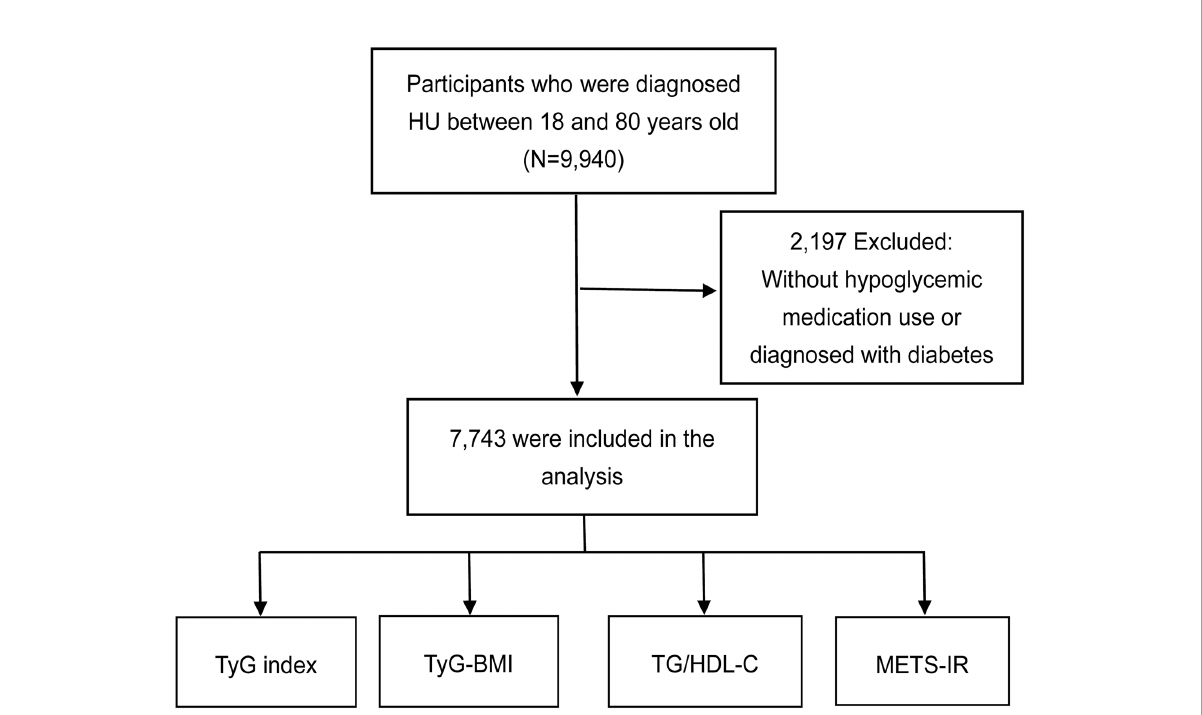
FIGURE 1 Flowchart of the study. HU, hyperuricemia; TyG, triglyceride glucose; TyG-BMI, triglyceride glucose with body mass index; TG/HDL-C, the ratio of triglycerides divided by high-density lipoprotein cholesterol; METS-IR, metabolic score for insulin